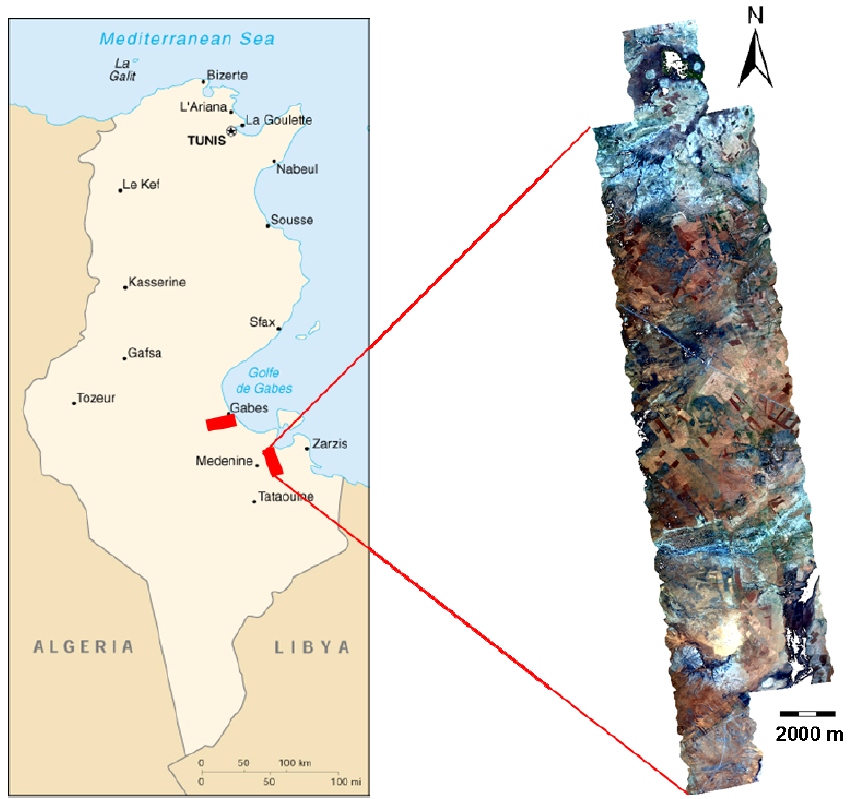
Figure 15. Location of the AquiferEx test sites in Tunisia and mosaic of three AVIS-2 flightstripes of the test site Ben Gardane (map source: